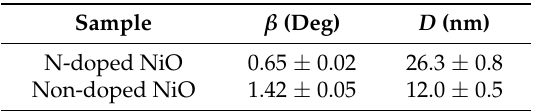
Figure 4. XRD results of N-doped and non-doped NiO NSs. Table 1. Structural crystal parameters of N-doped and non-doped NiO NSs.